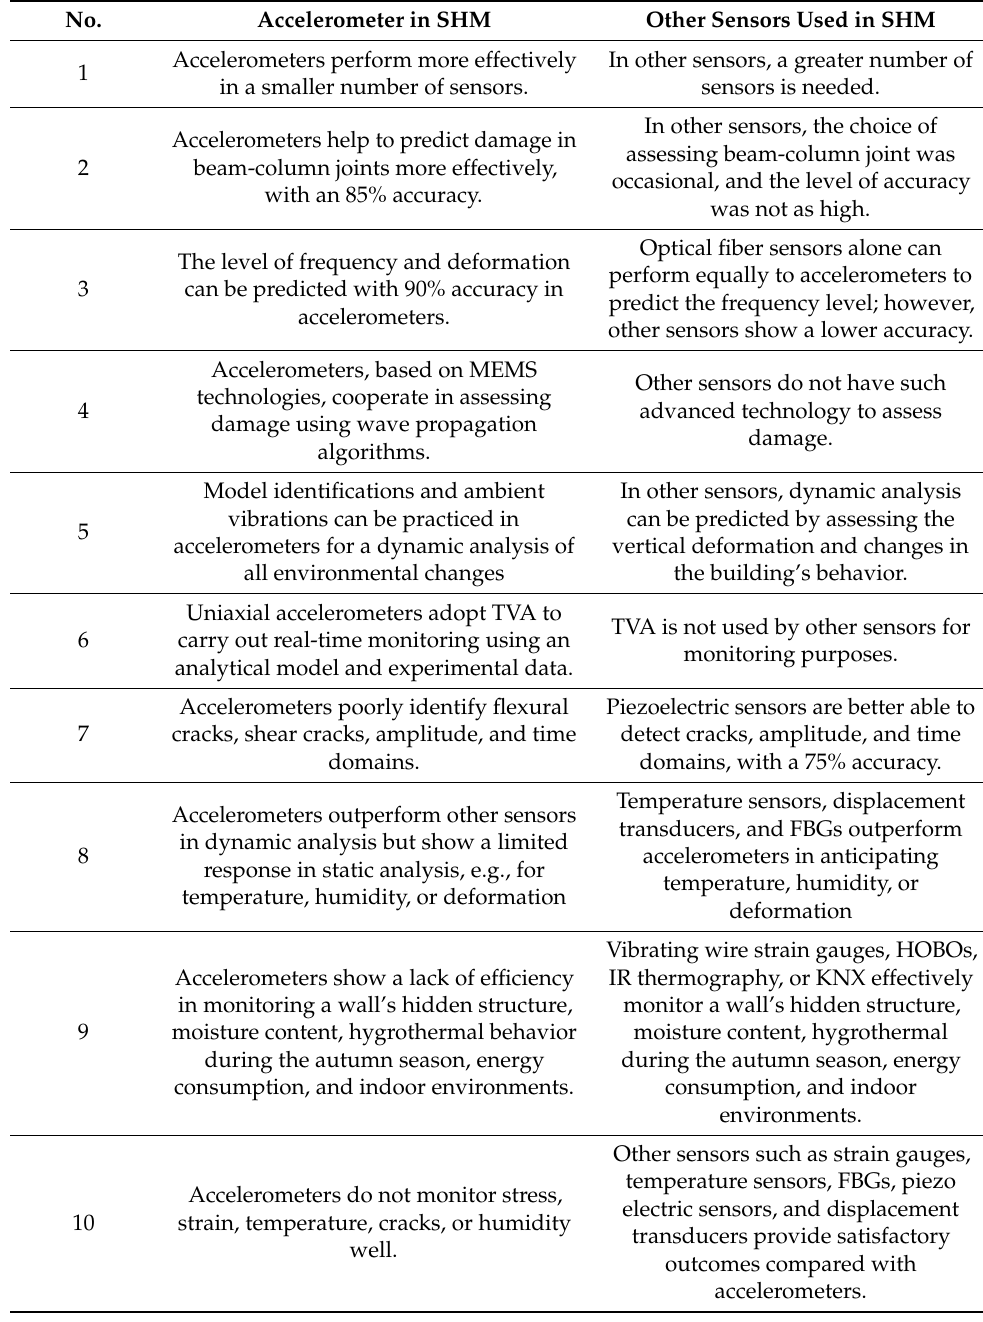
Table 1. Role of various sensors compared with